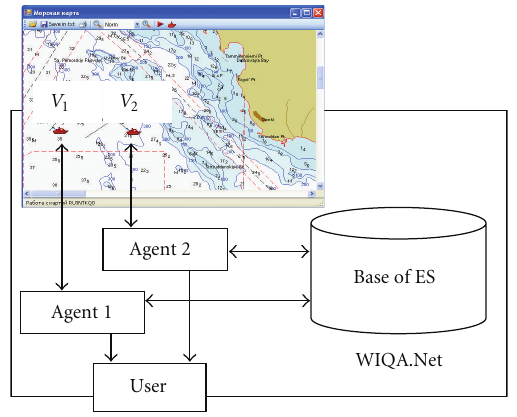
Figure 17: System for expert